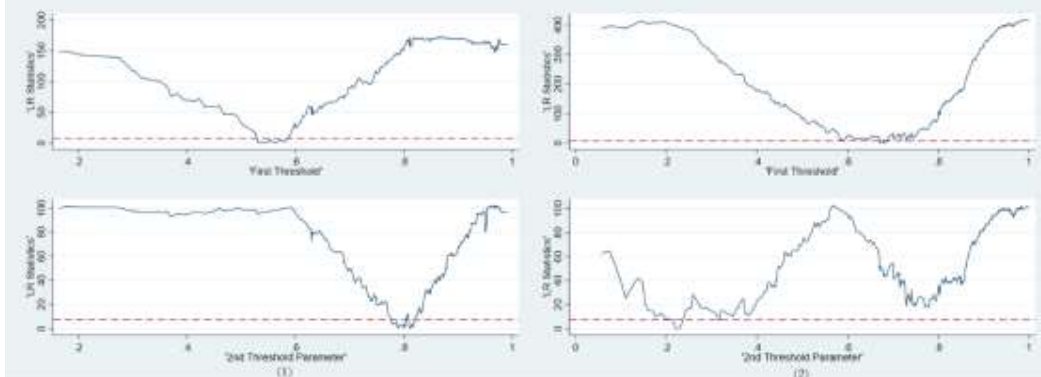
Figure A1. The likelihood ratio function diagrams. (1): Eastern cities; (2): Central-western cities. Table A1. The Global Moran’ I of per capita GDP carbon dioxide emissions.